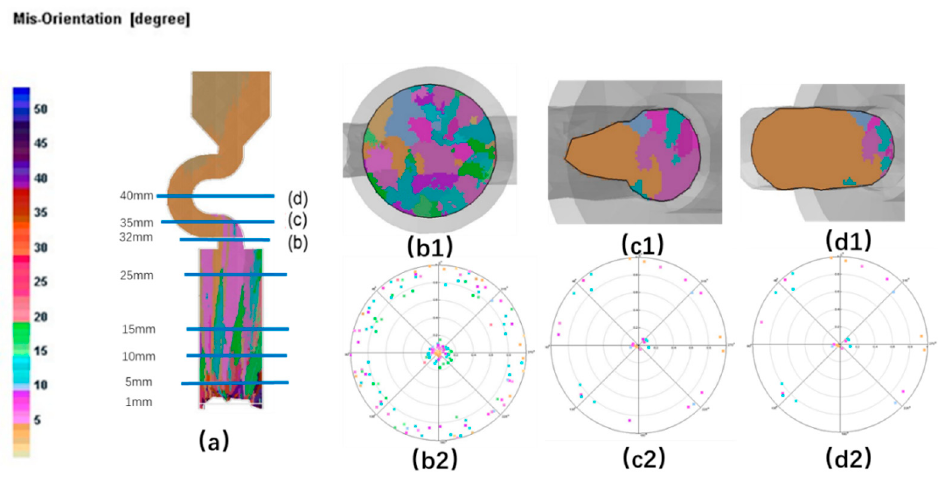
Figure 10. Simulation structure of C 4 (4 mm) ( a ); EBSD maps of the grain structure evolution ( b1 , c1 , d1 ) and the EBSD inverse pole figures ( b2 , c2 , d2 ).